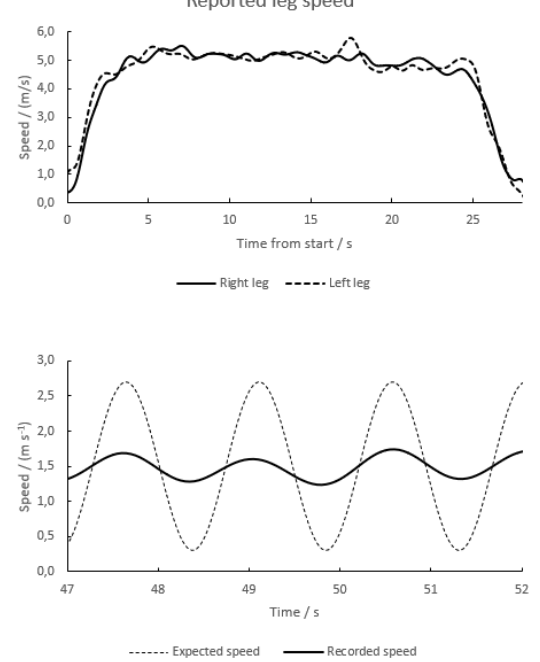
Figure 6. Upper panel, recordings of the speed of transponders being tied around the ankle of a test person running across the field at ≈ 5 m s –1 . The two curves are for the right and left legs, respectively. Lower panel, recordings of the speed of a transponder tied to the rim of a bicycle when rolled at constant speed across the field at 1.5 m s –1 , giving a time of ≈ 1.5 s/wheel cycle. The dashed curve gives the expected value of the true, unfiltered speed.